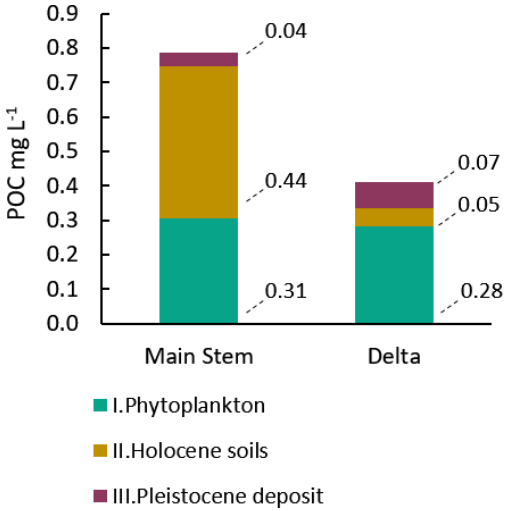
Figure 5. Contributions of different OM sources to the POC mea- sured in the Lena River main stem and the Lena delta along the transect in